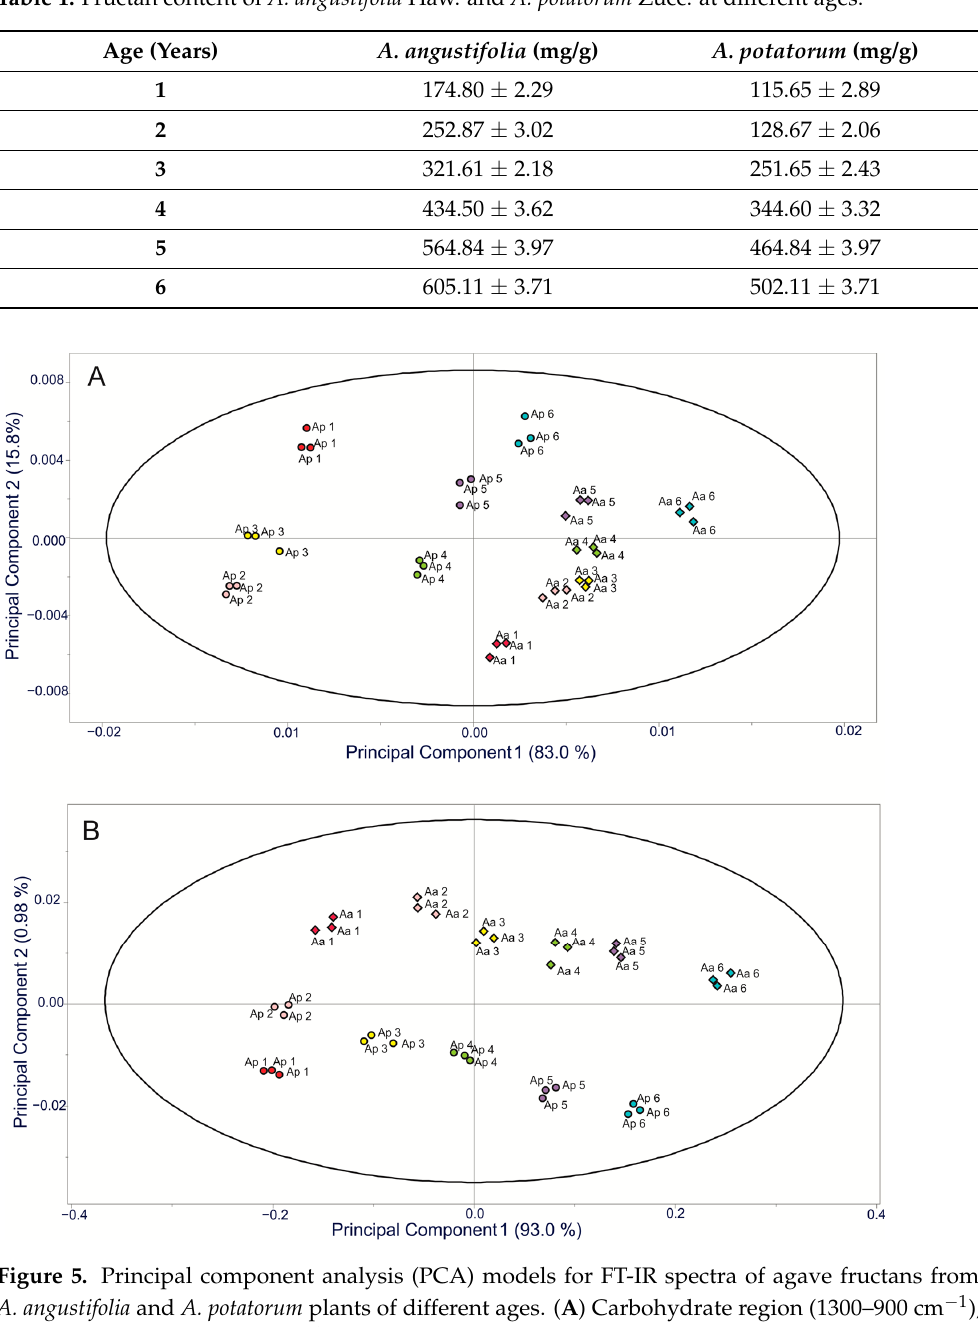
Table 1. Fructan content of A. angustifolia Haw. and A. potatorum Zucc. at different ages.